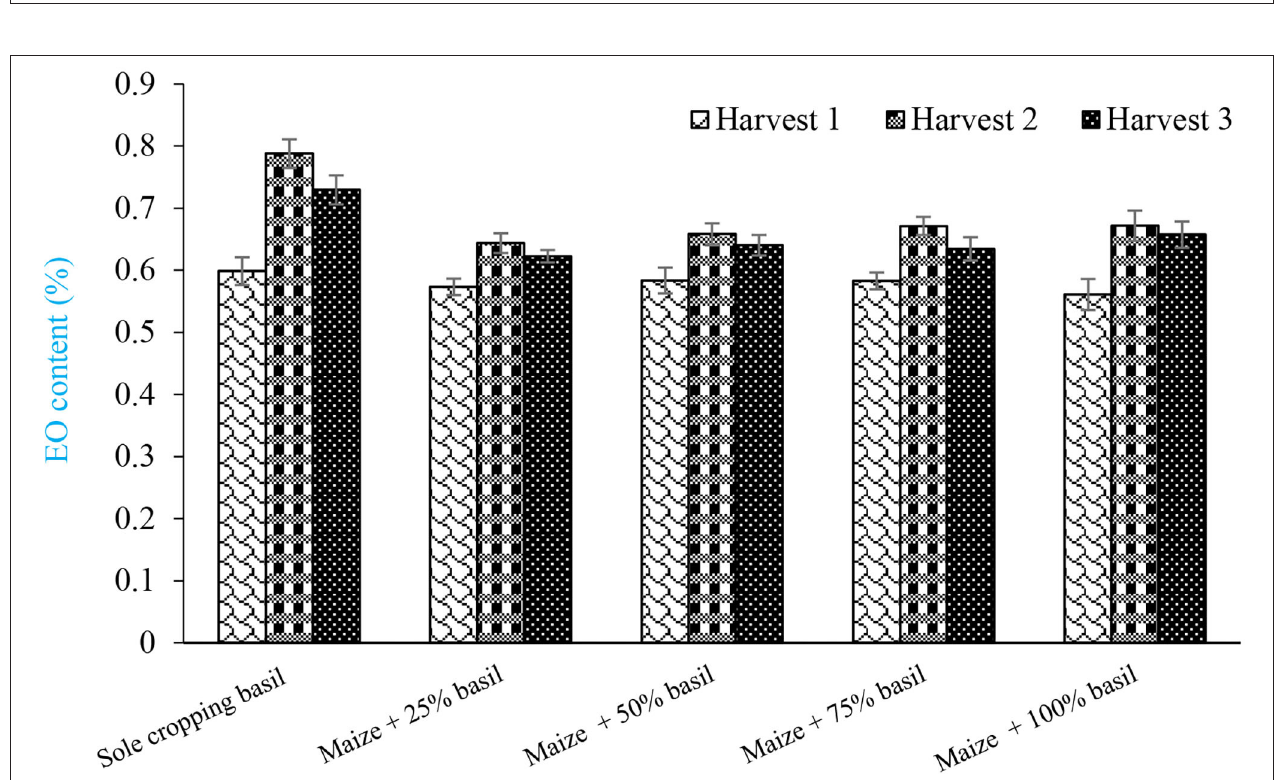
FIGURE 2 | Mean comparisons of interaction of cropping patterns and different harvest on content of basil essential oil.